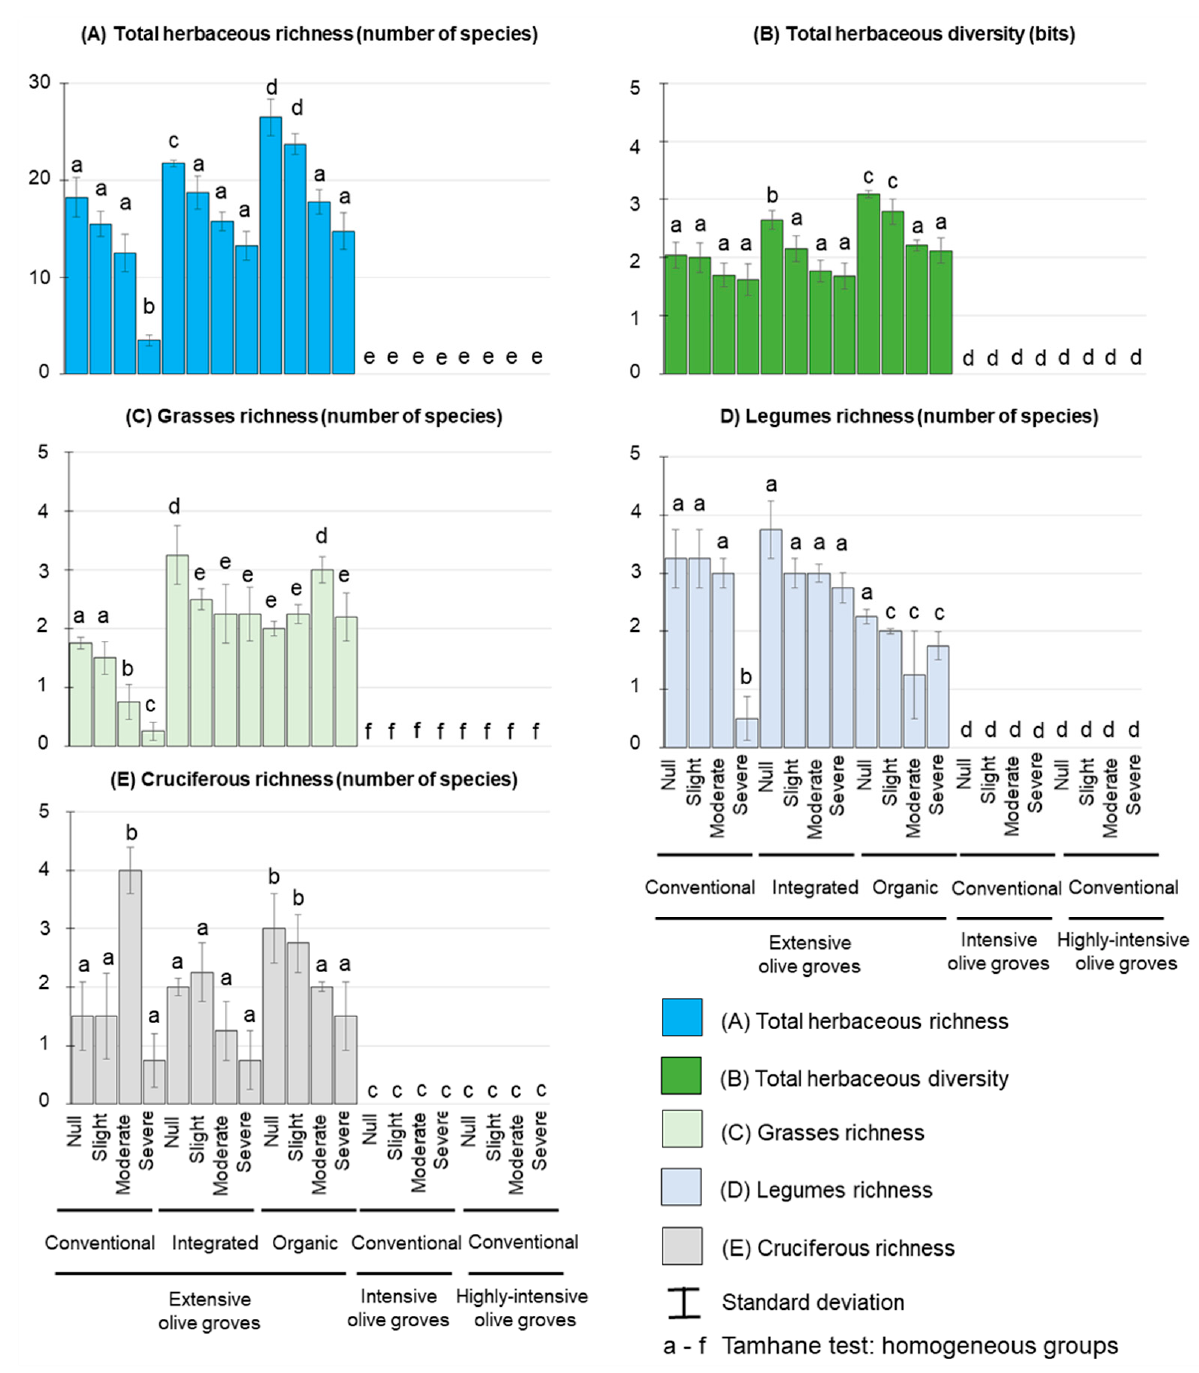
Figure 6. Mean values and standard deviations for total herbaceous richness ( A , number of species) and diversity ( B , bits) for each erosion level and type of olive grove. Additionally, mean values and standard deviations are also attached for the specific richness of grasses ( C ), legumes ( D ), and cruciferous ( E ). Indexes, a–f, indicate the clusters generated in the Tamhane post-hoc test to establish similar categories.